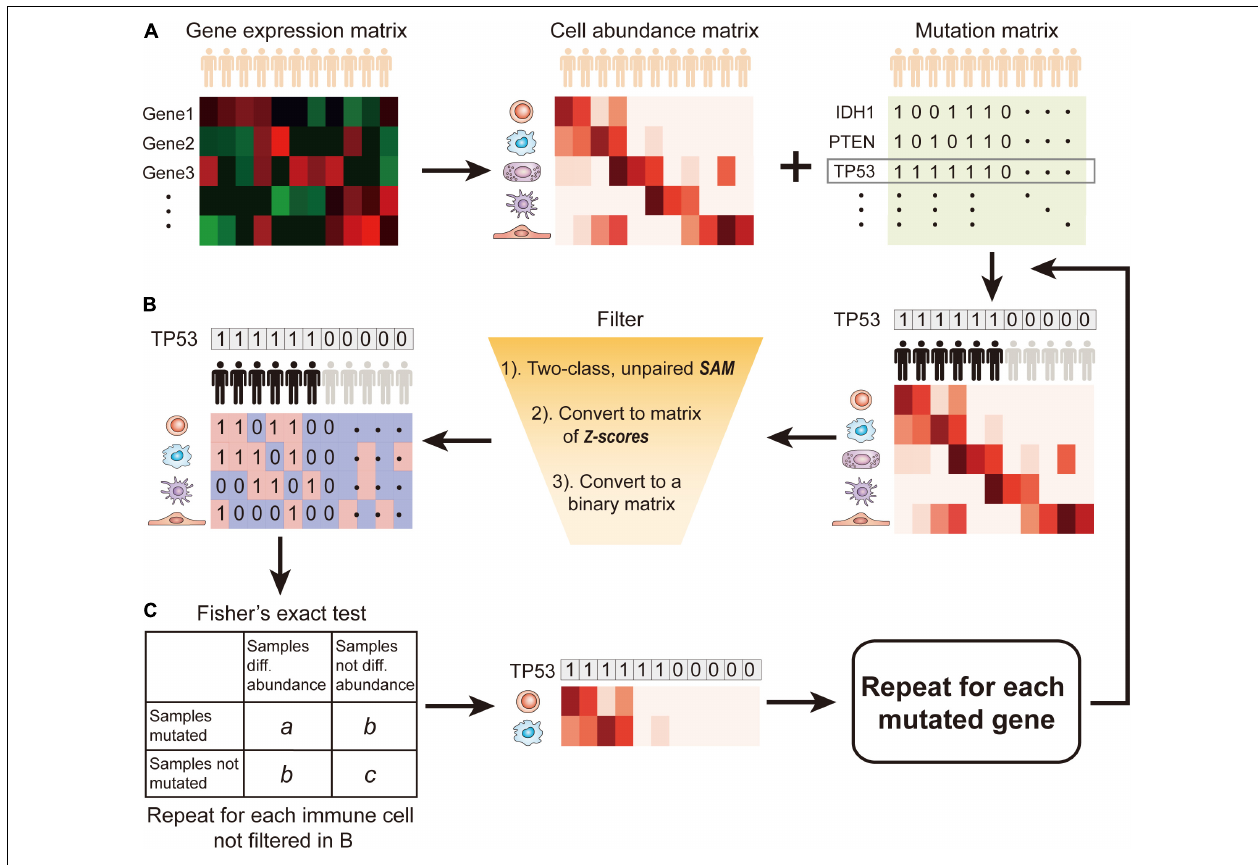
FIGURE 1 | Flow diagram of SMDIC. (A) Inference of the relative abundance matrix of immune cells; (B) Detection of differential abundance immune cells with respect to the gene mutation status; (C) Identification of significant immune cells associated with somatic